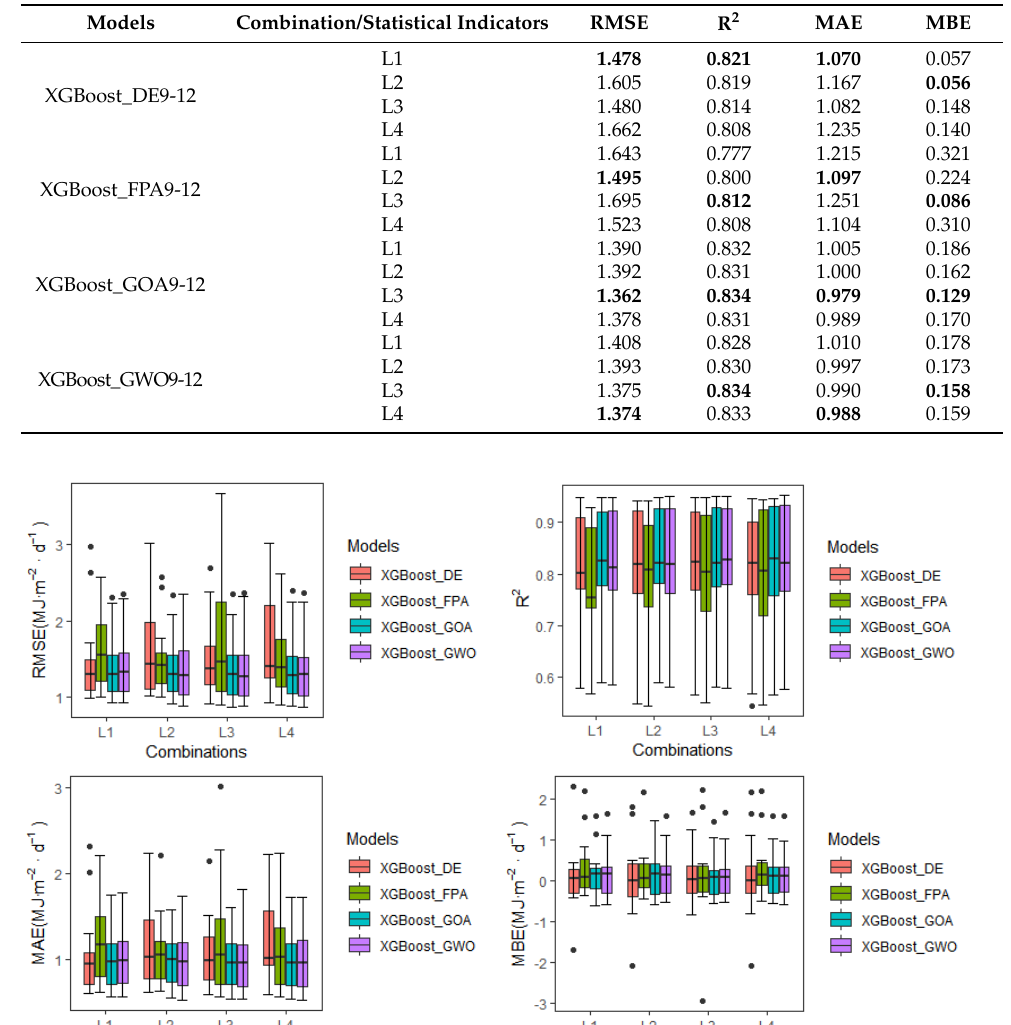
Table 7. Statistical results of the XGBoost_DE, XGBoost_FPA, XGBoost_GOA, and XGBoost_GWO models for R d prediction with four combinations based on ground weather stations data.